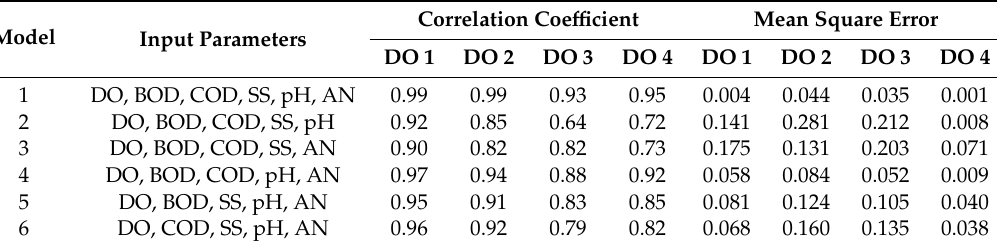
Table 6. Correlation coefficient for Scenario 1.